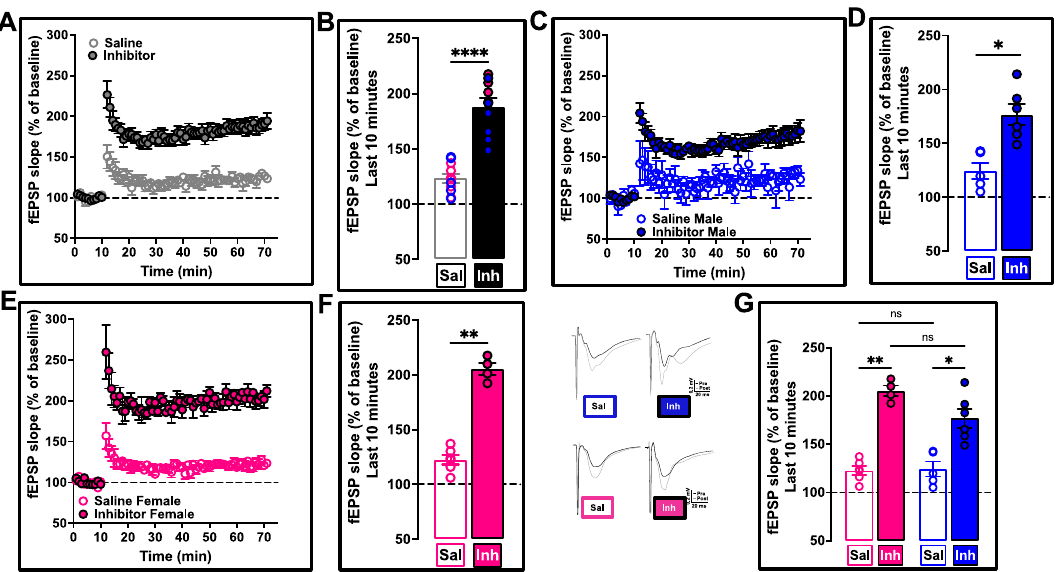
Figure 5. Preservation of HFS-LTP in the Schaffer collateral synapses by repeated VU01 treatment of 12-month-old 3xTg-AD mice. ( A ) Inhibitor-treated group (filled circles) showed increased potentiation compared to saline-treated sibling group (clear circles) following high frequency stimulation (HFS − 3 × 100 Hz) . ( B ) The last 10 minutes (from 60–70 min in the previous panel) were averaged to obtain the mean and standard error of mean for each animal to plot the bar graph of saline-treated (clear bar) compared to PLD1 inhibitor-treated (filled bar). When the data were separated into males (**** p < 0.0001, n = 9–10 mice; unpaired non-parametric Mann–Whitney test). ( C , D ) * p < 0.0166; n = 5–6 mice, Uncorrected Dunn’s test) and females ( E , F ) ** p < 0.0015; n = 4–6 mice, Uncorrected Dunn’s test), the PLD1 inhibitor effect is seen in both sexes. We also assessed whether the sex-dependent increase showed differences between and within the treatment groups ( G ) ** p > 0.9999 for saline (male vs. female) and * p = 0.3491 for inhibitor (male vs. female); Uncorrected Dunn’s test, there was no significant difference, suggesting that the synaptic changes were comparable between the sexes. Representative traces for each sex (pink for females and blue for males) and treatment group (Sal vs. Inh) are provided. Each panel provides two overlapping sets of traces with pre-HFS (black) and post-HFS (grey) profile. Scale bars showing the amplitude in mV along the Y-axis (0.2 mV) and time in milliseconds (20 ms) along the X-axis for each panel. Each circle in ( B , F , D , G ) represents an animal. Saline circles have colored borders while inhibitor circles have black outline filled with color. Values are expressed as mean ± SEM. ns, no significance.